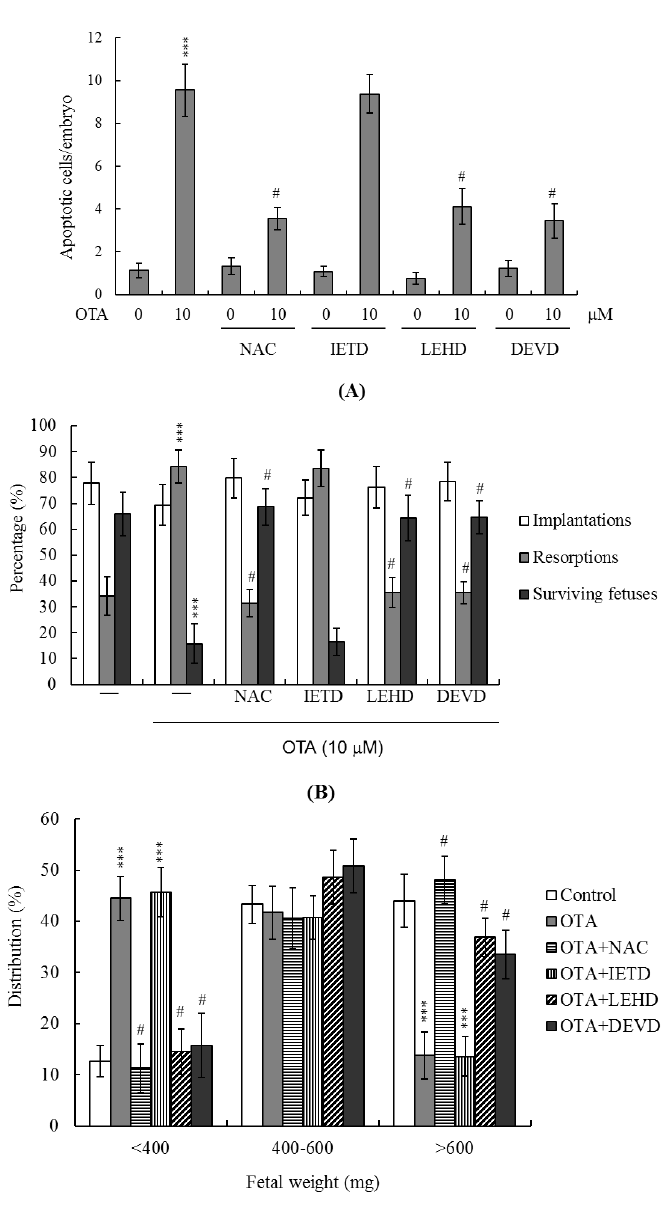
Figure 6. Effects of ROS scavengers and caspase inhibitors on in vivo implantation, resorption, fetal survival, and fetal weight, after treatment of embryos with OTA. Mouse blastocysts were pretreated with 400 μM N -acetyl cysteine (NAC), 300 μM